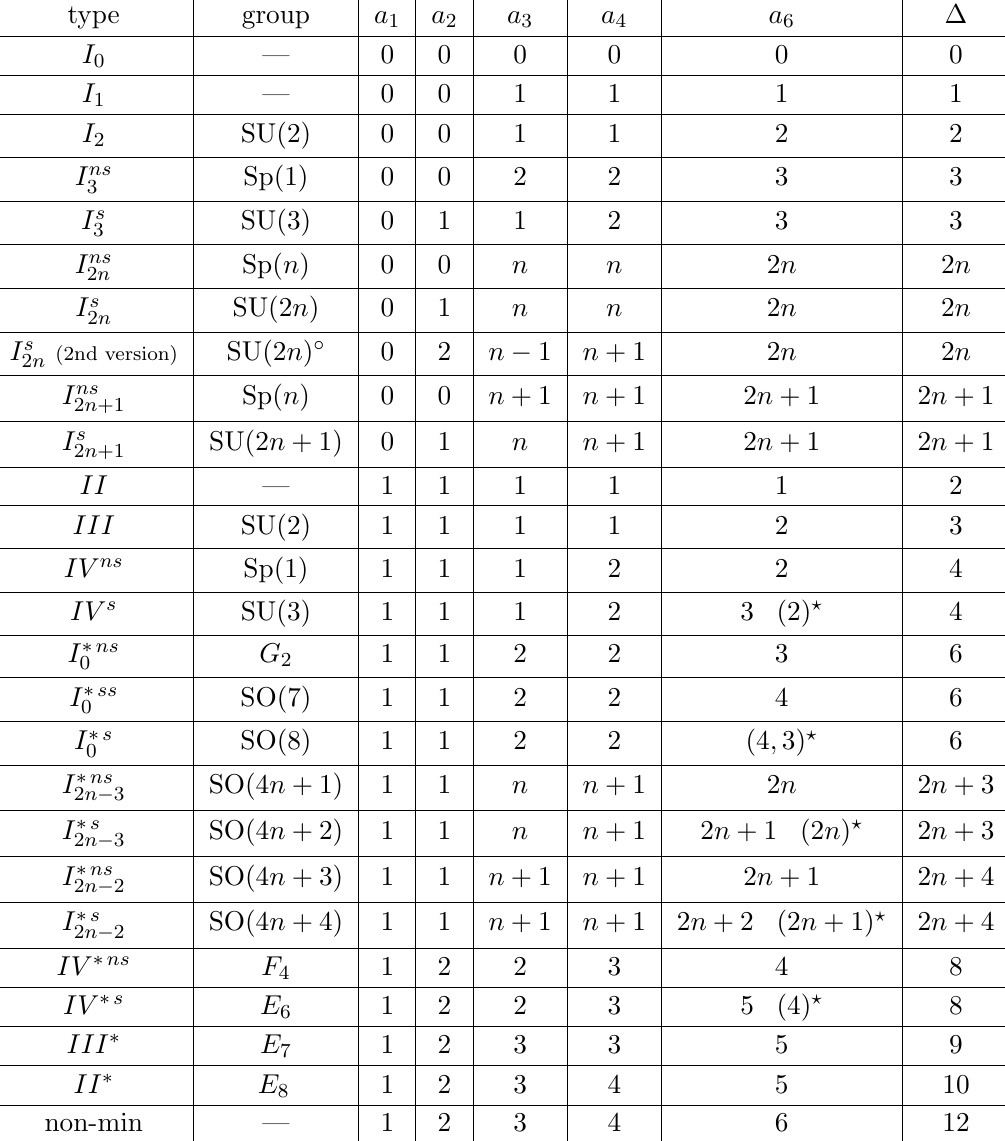
Table 4. Tate forms: extends earlier versions of table by including alternative SU(2 n ) and SO(2 k ) tunings that can be realized purely by orders of vanishing without additional monodromy con- straints. In particular, alternate tuning ( (cid:14) ) of SU(6) gives alternate exotic matter content; see text for further details. Groups and tunings marked with ? require additional monodromy conditions.